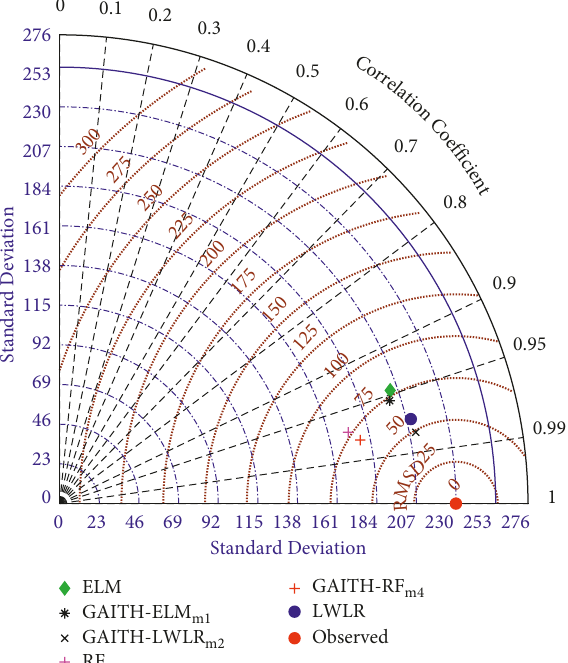
Figure 16: The Taylor diagram shows the improvement in pre- diction by the feature selection algorithm: testing